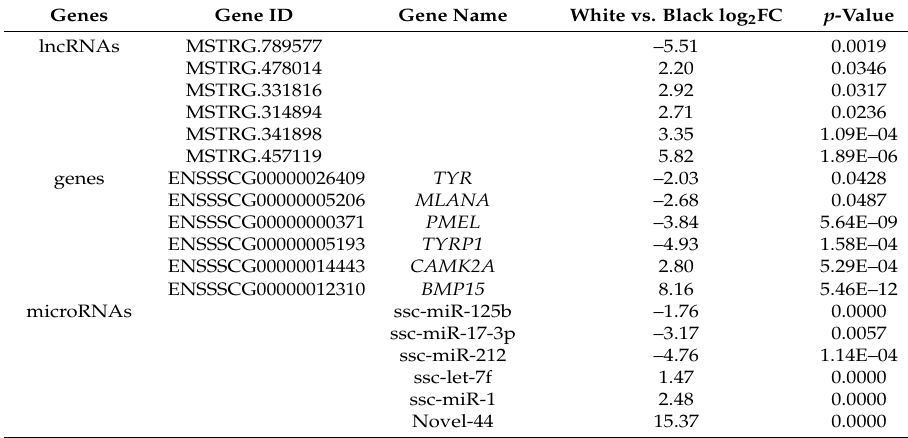
Table 1. Differentially expressed lncRNAs, genes and miRNAs in white vs. black skin from black-back/ white-belly Wuzhishan